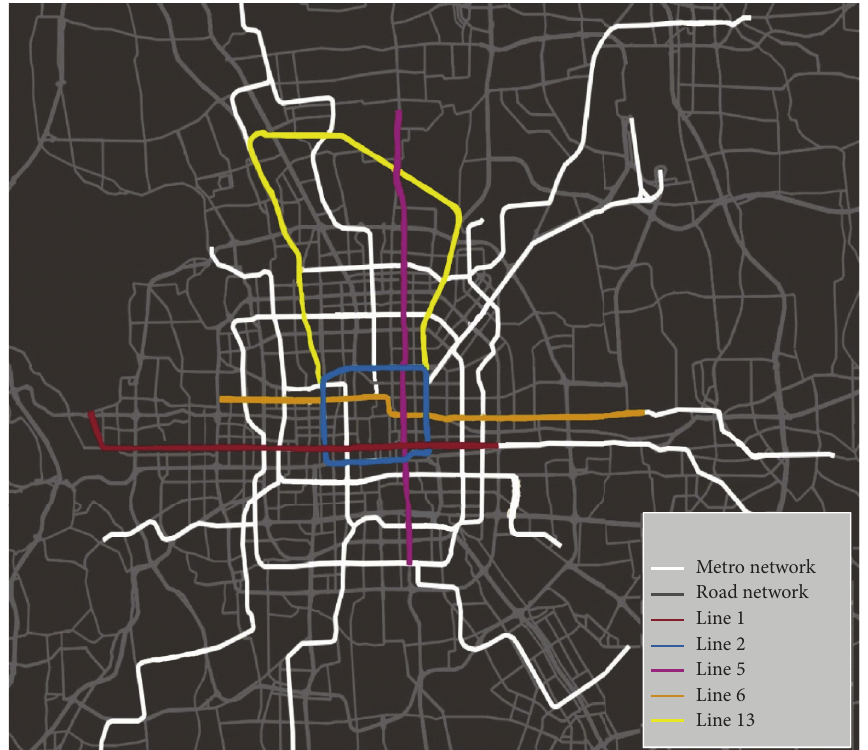
Figure 1: The subway real physical network of the BSS. The metro network and the road network are presented by white and gray lines, respectively. Moreover, the five lines we studied in this paper are shown by